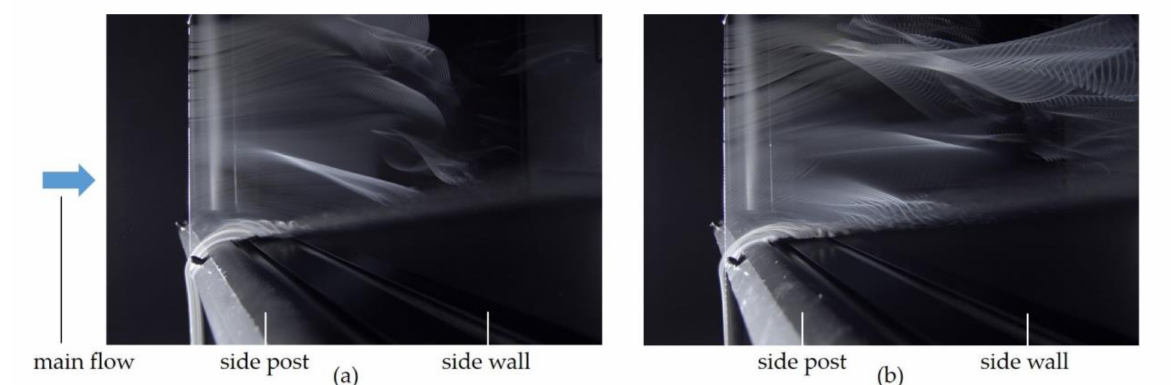
Figure 21. Streaklines in the area of side post and side wall: ( a ) fume hood with improved jet nozzles, steady outflow, .